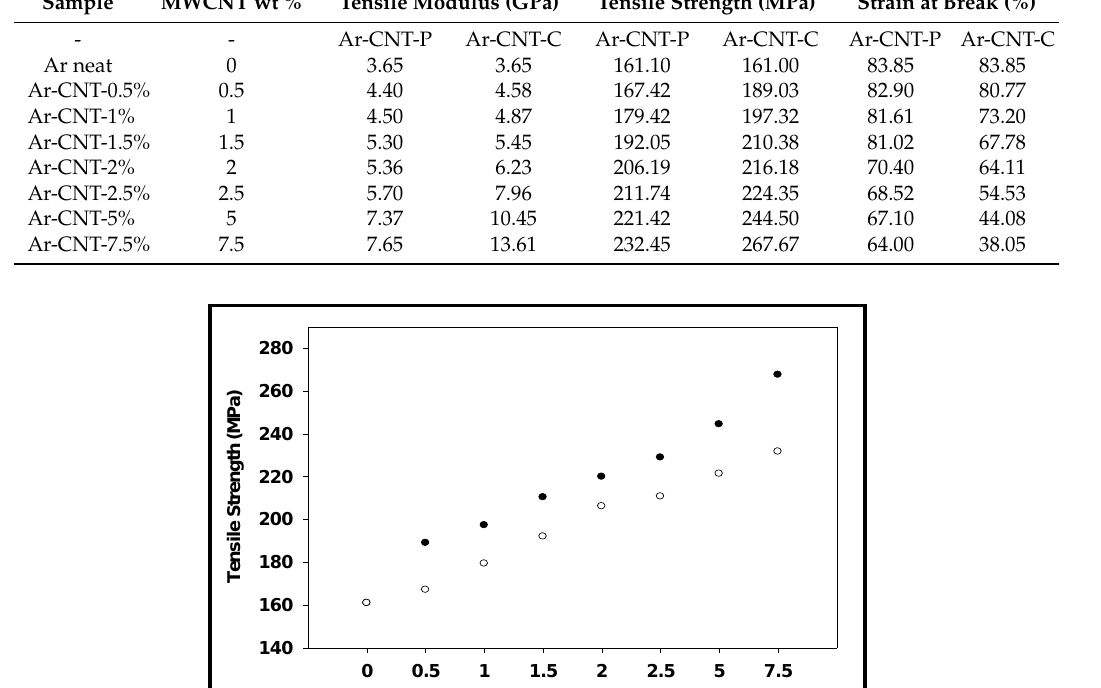
Table 1. Tensile Properties of Ar-CNT-P and Ar-CNT-C Composites. MWCNT: multiwalled carbon nanotubes.